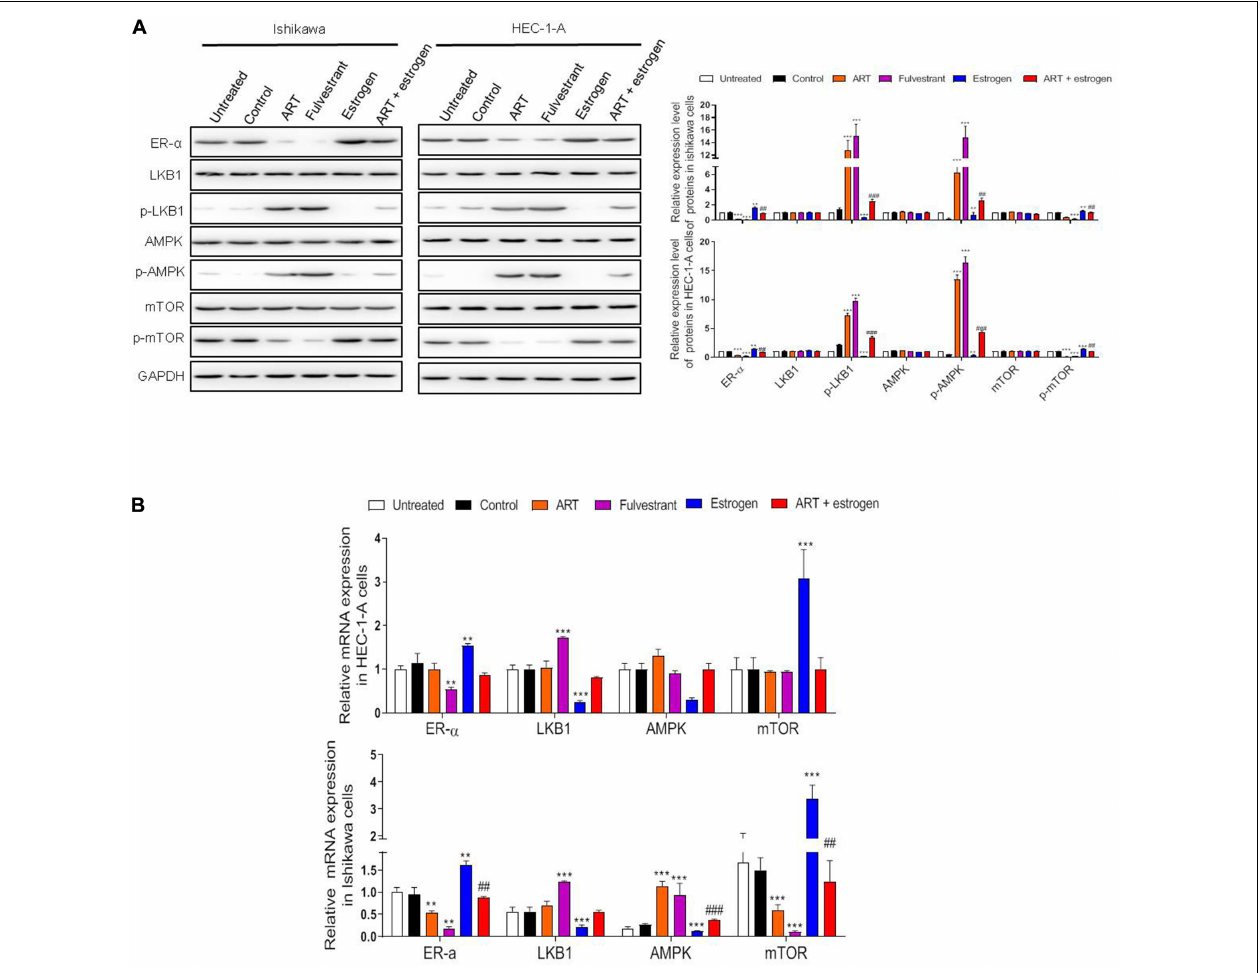
FIGURE 3 | Artesunate (ART) inhibited the proliferation of Ishikawa and HEC-1-A cells via regulating the ER- α related LKB1/AMPK/mTOR pathway. Ishikawa and HEC-1-A cells were treated with PBS, ART (30 µ g/mL), fulvestrant (250 nM), estrogen (10 nM) or ART + estrogen for 4 days. (A) Representative blot and analysis were performed for the protein levels of ER- α , LKB1, p-LKB1, AMPK, p-AMPK, mTOR, p-mTOR in these cells. (B) The mRNA levels of these genes were performed by qRT-PCR analysis. The data were showed as the mean ± SD, ** p < 0.01, *** p < 0.001 vs. the control group; ## p < 0.01, ### p < 0.001 vs. the ART-treated